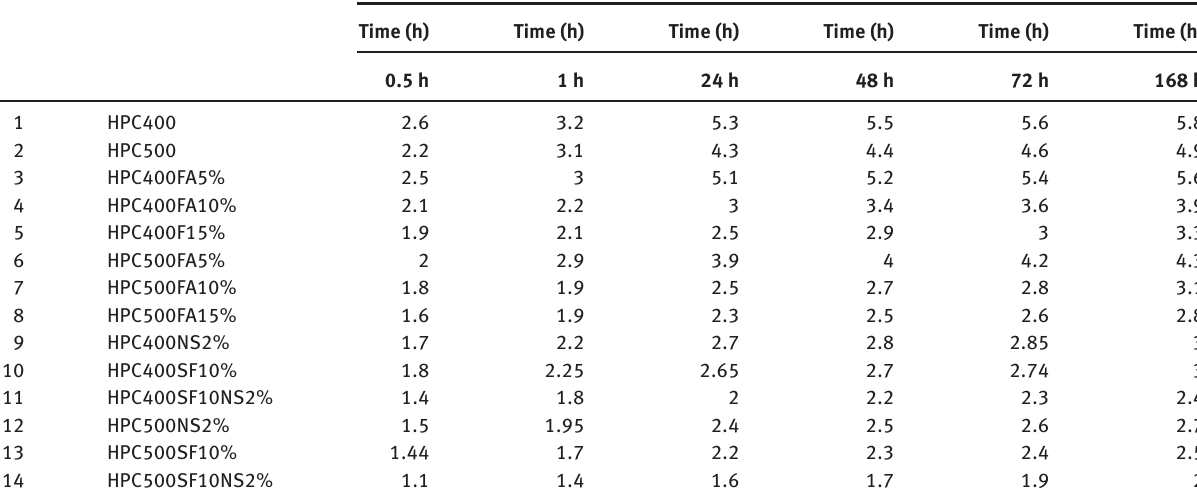
Table 6 Results of water absorption by time.